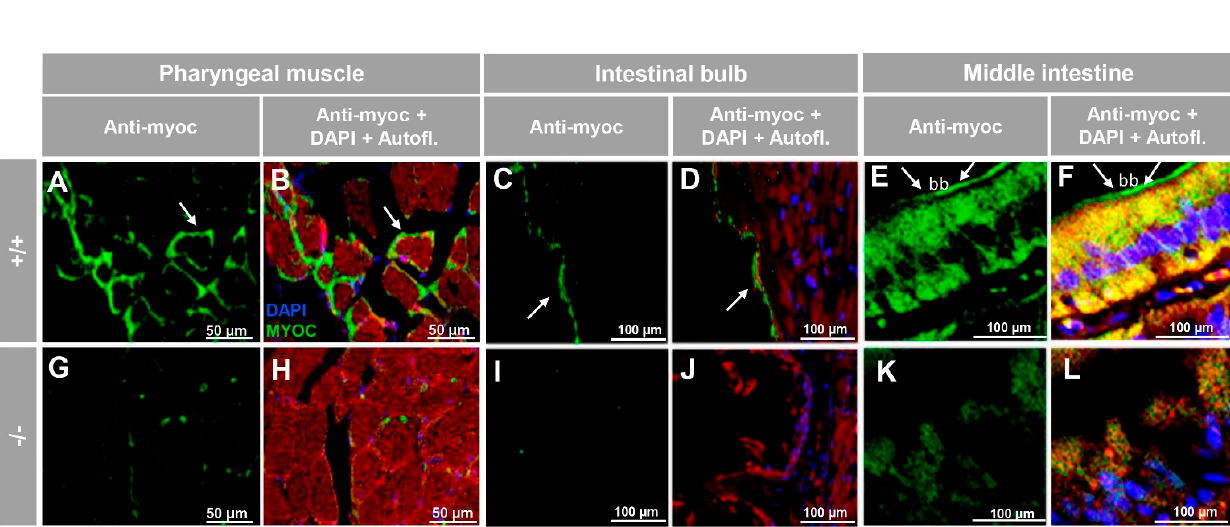
Figure 6. Immunohistochemistry of myocilin in non-ocular tissues of adult zebrafish. Wild-type and myoc KO adult (7 months) zebrafish tissue sections (14 µ m) were incubated with a chicken anti-myocilin (TNT) primary antibody and a Cy2-conjugate goat anti-chicken IgY secondary antibody. Arrows show immunostaining in the periphery of pharyngeal muscular fibres ( A , B , G , H ), the enterocyte apical side in the intestinal bulb ( C , D , I , J ) and in the brush border of the epithelial cells in the middle intestine ( E , F , K , L ). Red signals correspond to tissue autofluorescence. bb: brush border. The images are representative of the results observed in three tissue sections from three animals. +/+: wild-type; − / − : myoc KO. Negative controls are shown in Figure S5.